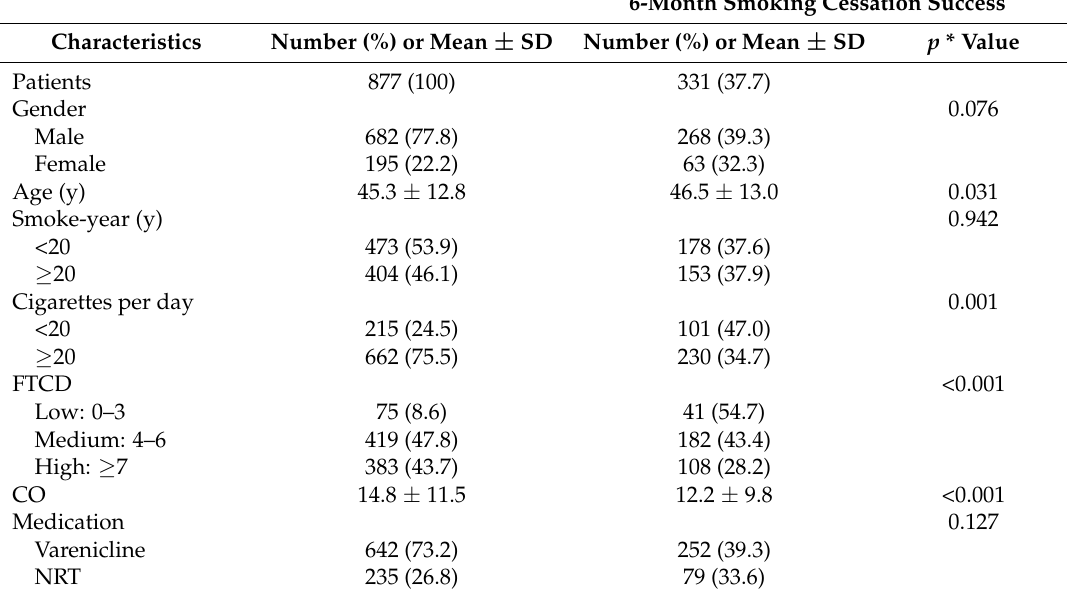
Table 1. Characteristics of patients and physicians correlated with six-month smoking cessation success